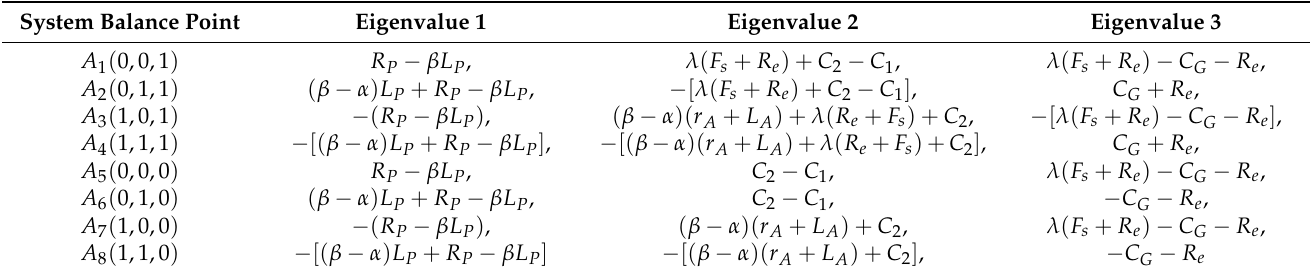
Table 3. Eigenvalues corresponding to system equilibrium